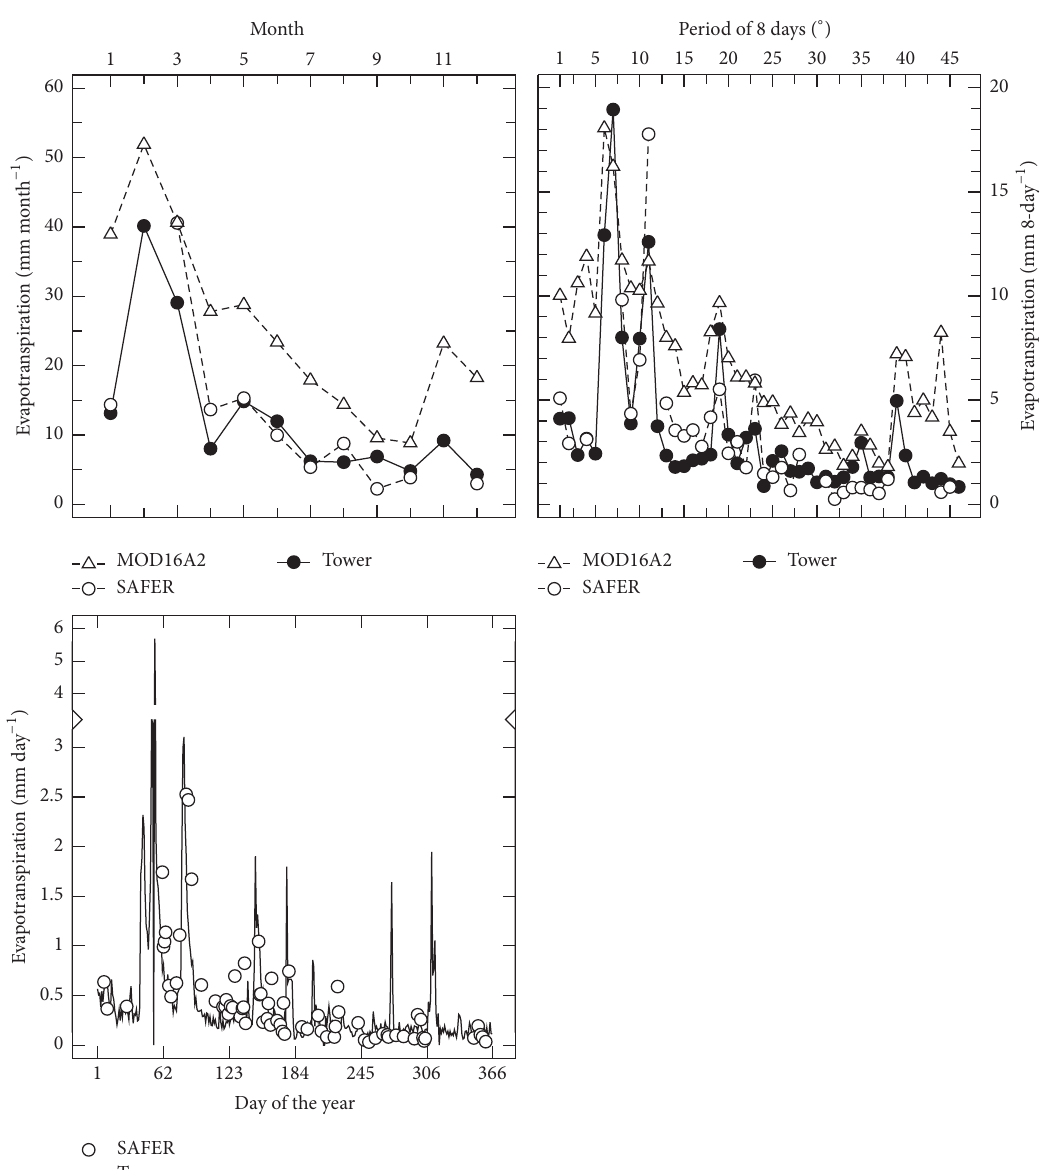
Figure 9: Monthly, 8-day, and daily variations of MOD16A2 and SAFER evapotranspiration and evapotranspiration from a Flux tower installed in an area of Caatinga at Embrapa Semi´arido, which is a research station of the state of Pernambuco, Brazil, for the year of